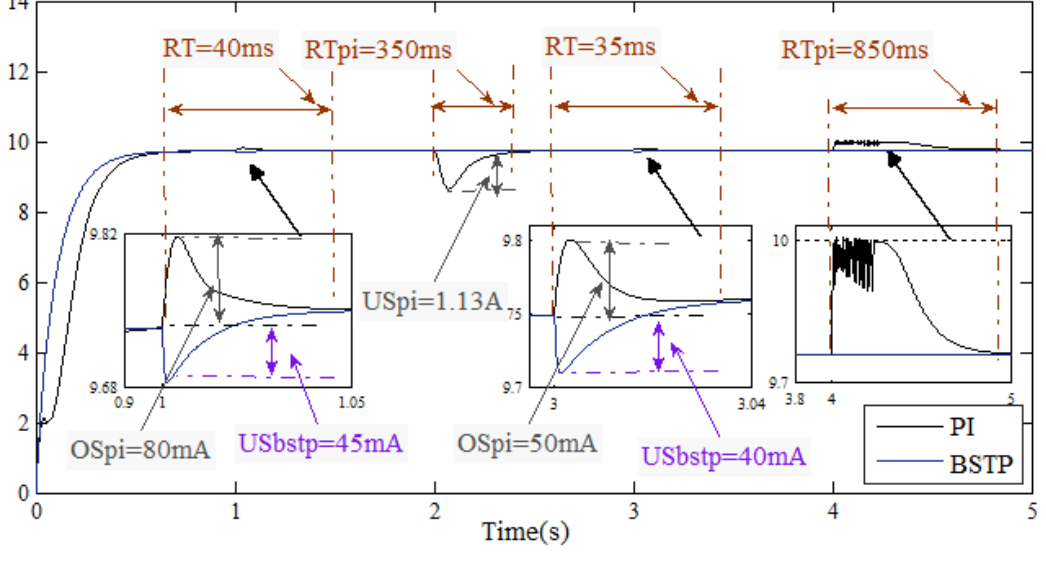
Figure 14. PEM fuel cell stack current.